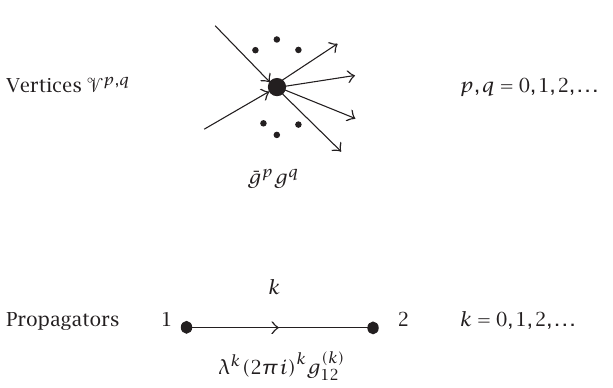
Figure 1.1 . Feynman rules of the ζ